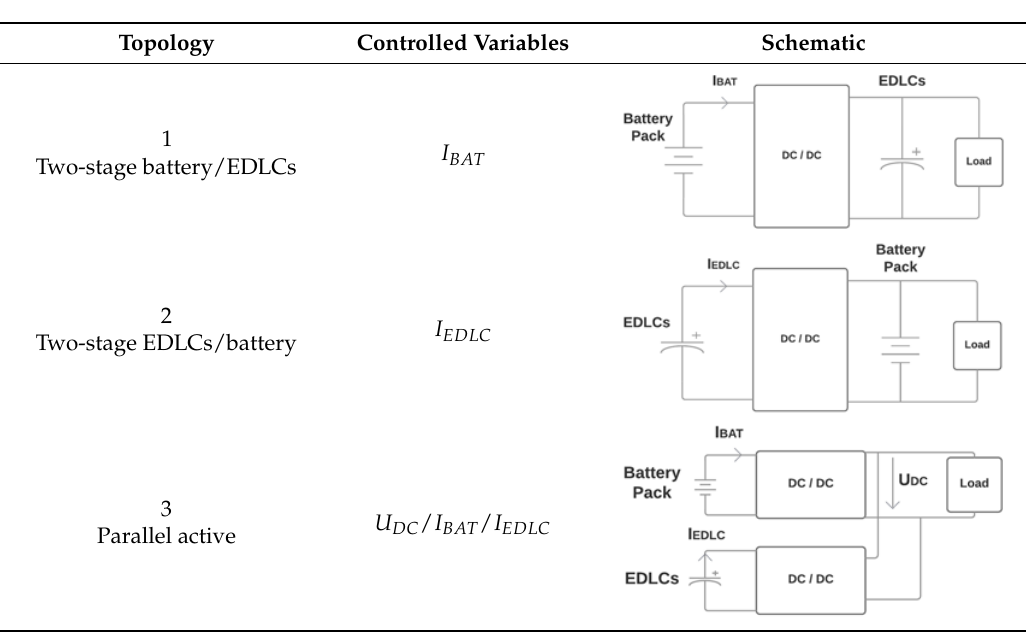
Table 1. The two ‐ source one ‐ load Hybrid Energy Storage Systems (HESS) boost topologies studied for this paper.